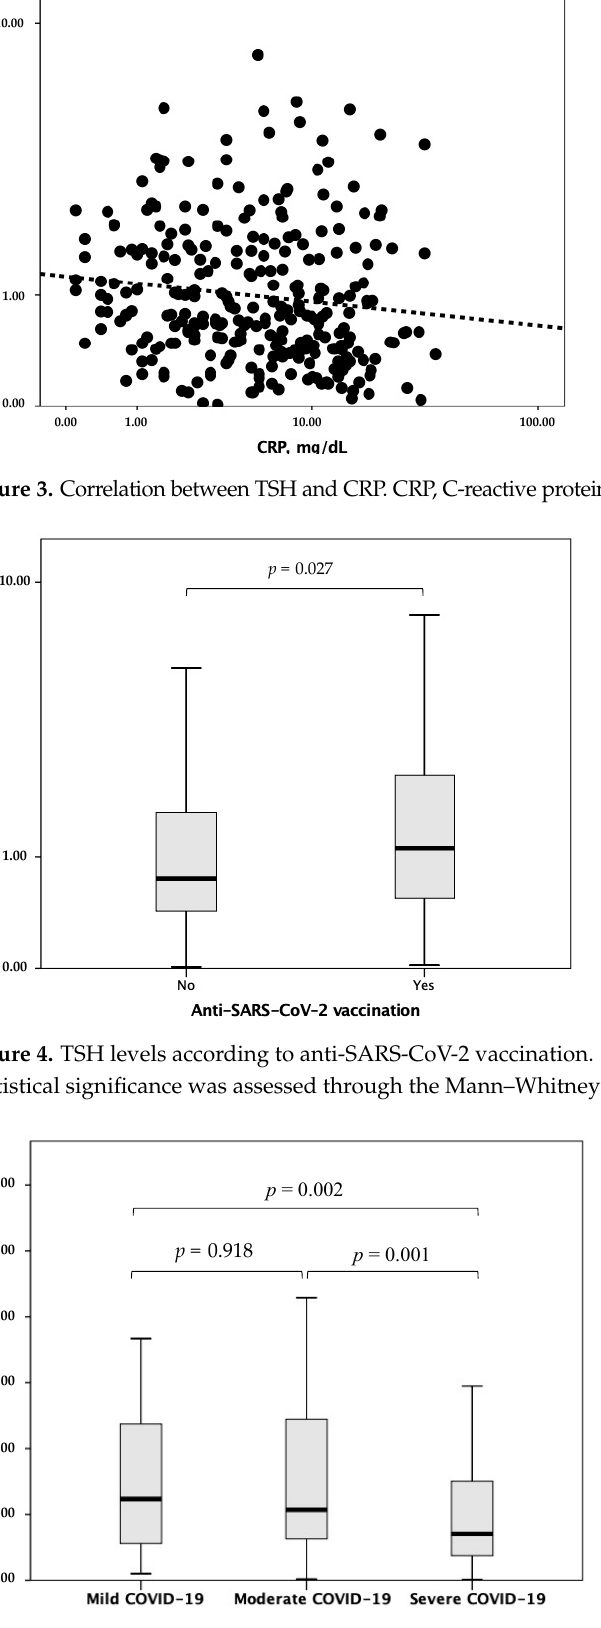
Figure 5. TSH levels according to COVID-19 severity. TSH, thyroid-stimulating hormone; COVID-19, coronavirus disease 2019. Statistical significance was assessed through the Mann–Whitney U-test.